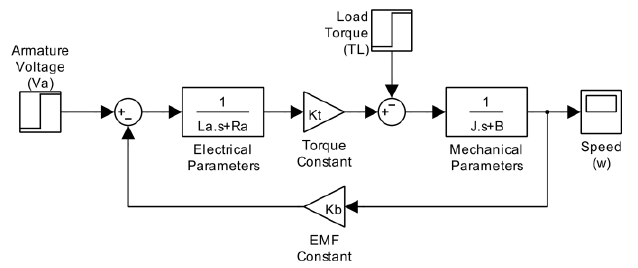
Figure 1. DC motor block diagram